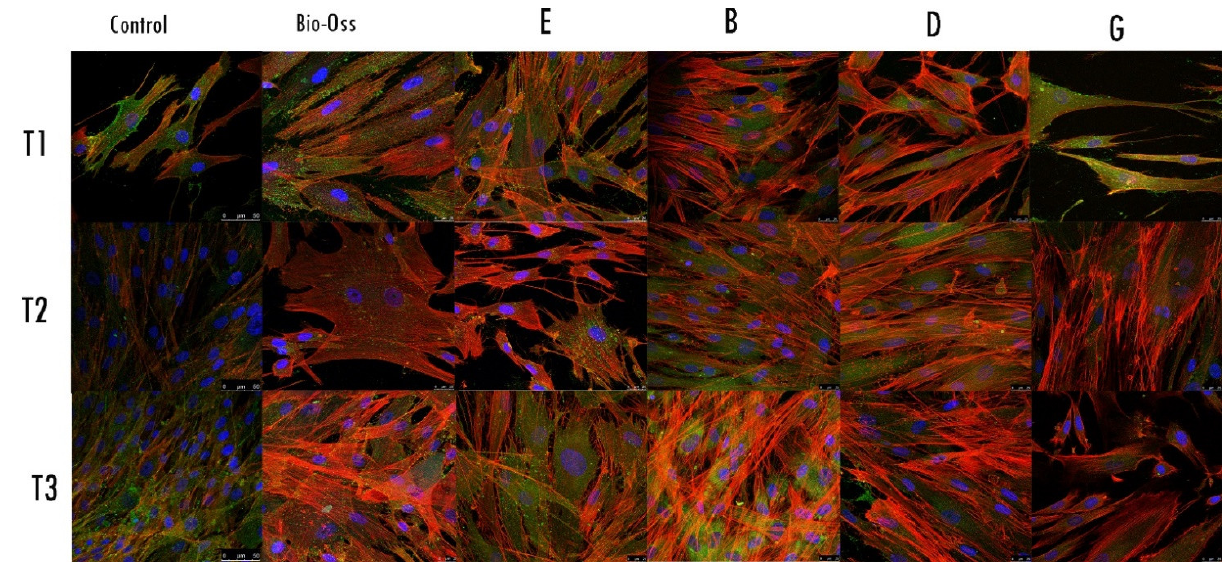
Figure 5. Confocal laser scanning microscopy (CLSM) images showing actin filaments using phal- loidin in control and treated fibroblasts marked with CD90 (green), at different times of follow-up; magnification 63 × .